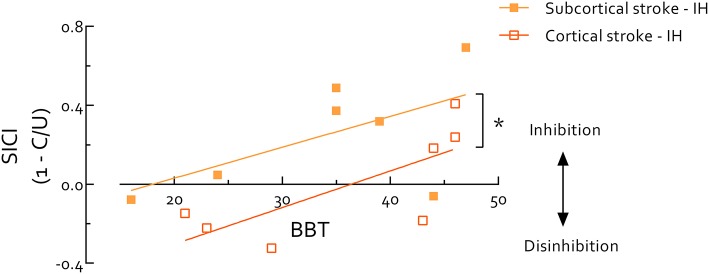
Short intracortical inhibition (SICI) in ipsilesional hemisphere measured during performance of box and blocks (B and B) correlates with box and blocks test (BBT) score in the paretic hand in stroke survivors. *indicates significant difference (P < 0.05). Overall correlation reveals an association between SICI during movement and motor function (r = 0.56, P = 0.039). BBT scores span a similar range between cortical and subcortical stroke survivors, but the intercept is significantly lower (P = 0.01) in cortical stroke indicating systematically reduced SICI during B and B compared to subcortical stroke. Of note, background EMG activity, S2 MEP size, and MEP/EMG during B and B were not significantly correlated with BBT score, therefore do not contribute to the correlation between SICI and BBT score. IH, ipsilesional hemisphere; MEP, motor-evoked potential. MEP/EMG refers to the ratio of S2 (unconditioned) MEP size to mean prestimulus EMG activity.